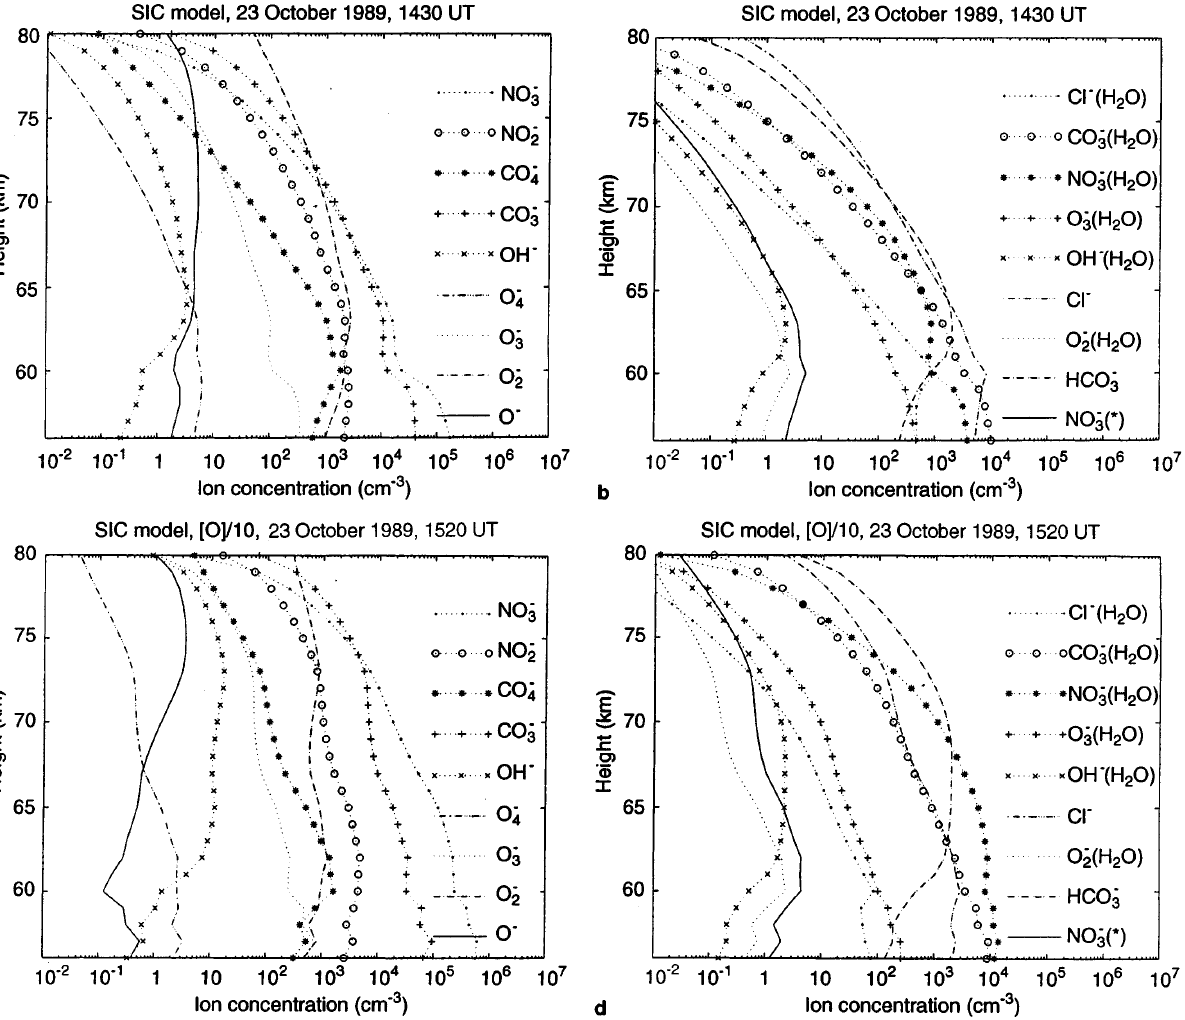
Fig. 10a–d. Concentration of the 18 most abundant negative ions at 1430 UT (zenith angle 91 : 1 (cid:14) , a and b ), and at 1520 UT (zenith angle 95 : 1 (cid:14) c and d ). AT 1520 UT the concentration of atomic oxygen was reduced by a factor of 10 from its daytime